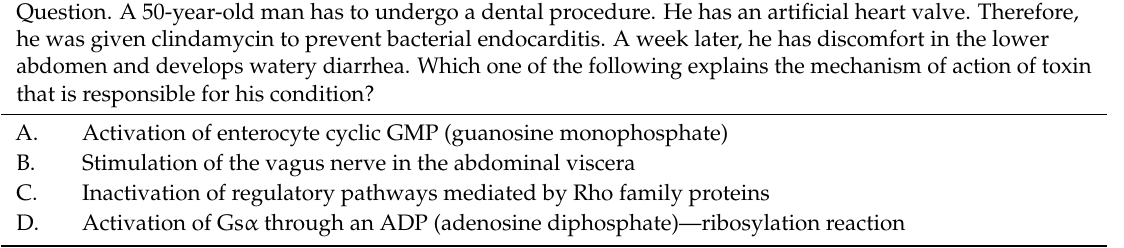
Table 3. Example of a quiz